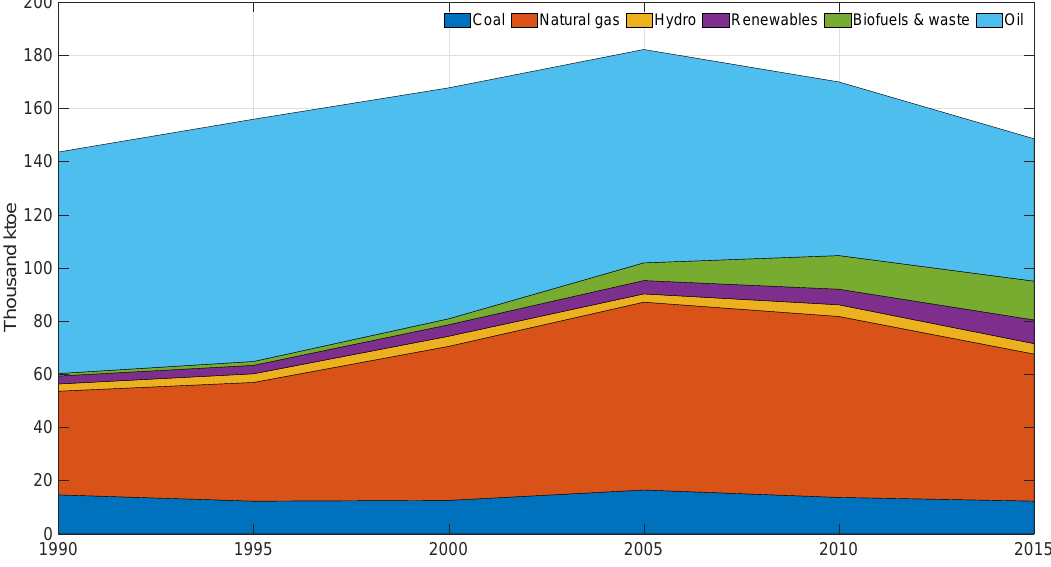
Figure 1. Energy mix of the primary energy supply, own analysis based on data from the International Energy Agency (IEA)